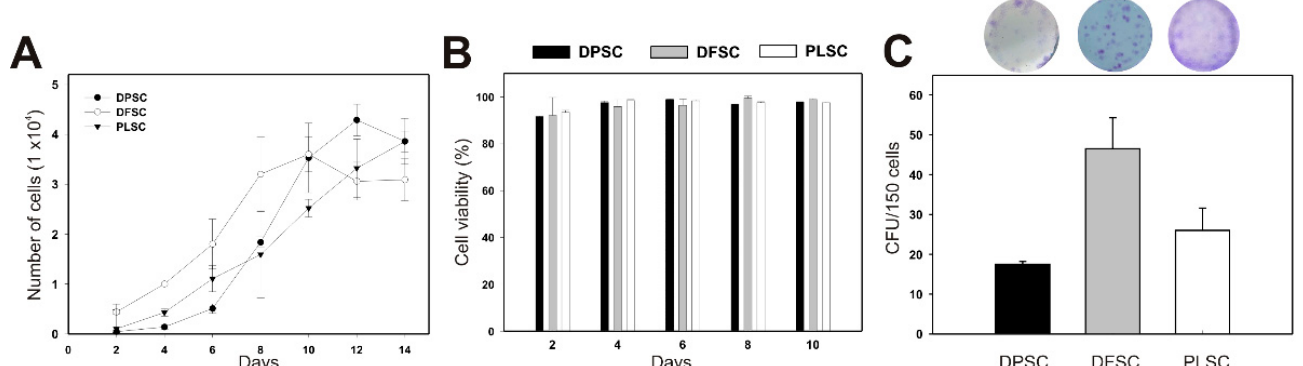
Figure 2. Proliferation, viability, and colony-forming parameters of dental pulp stem cells (DPSCs), dental follicle stem cells (DFSCs), and periodontal ligament stem cells (PLSCs). ( A ) Growth kinetics of DFSCs, DPSCs, and PLSCs cultured in α -MEM + 10% FBS for 14 days at 1 × 10 4 cells/well. ( B ) Cell viability of dental stem cells (DFSCs, DPSCs, and PLSCs) determined every 48 h for 10 consecutive days. ( C ) Unit-forming colony assay of DFSCs, DPSCs, and PLSCs determined after 14 days of culture. Error bars represent the standard deviation of the mean from three independent experiments ( p < 0.05).